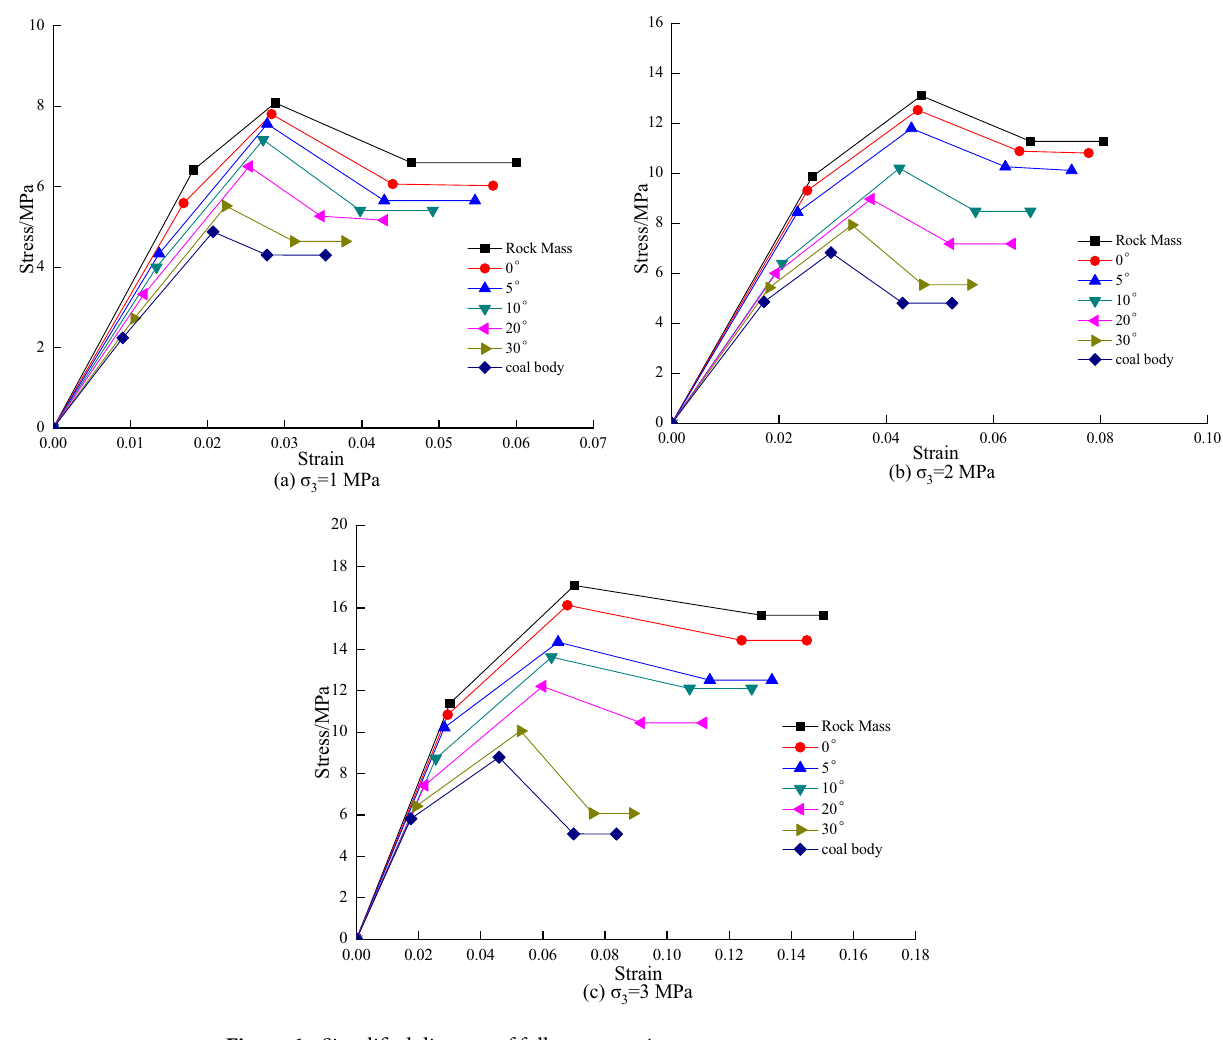
Figure 6. Simplified diagram of full stress–strain curve.